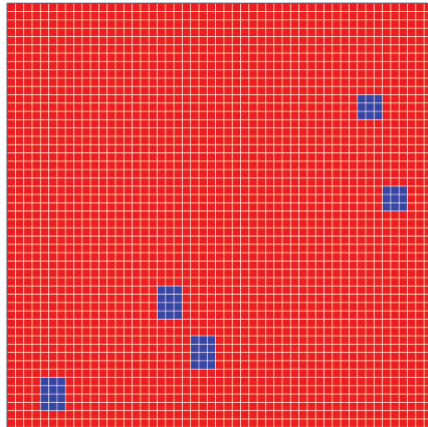
Figure 13: Simulation results on a 50 × 50 square lattice with Moore neighborhood and self-playing. The initial distribution of cooperators and defectors is randomly generated. The pattern is performed by the parameters region 𝑢 𝑖 0 > 𝑢 𝑖+2 1 (𝑖 = 1, 2, 3) , 𝑢 𝑖 0 < 𝑢 𝑖+2 (𝑖 = 4, 5,6) ; 𝑢 𝑖 > 𝑢 𝑖+2 (𝑖 = 1, 2, . . . , 4) , 𝑢 𝑖 < 𝑢 𝑖+2 (𝑖 = 5, 6) ; 1 0 1 0 1 𝑢 𝑖 > 𝑢 𝑖+2 (𝑖 = 1,2,...,5) , 𝑢 6 < 𝑢 8 0 1 0 1